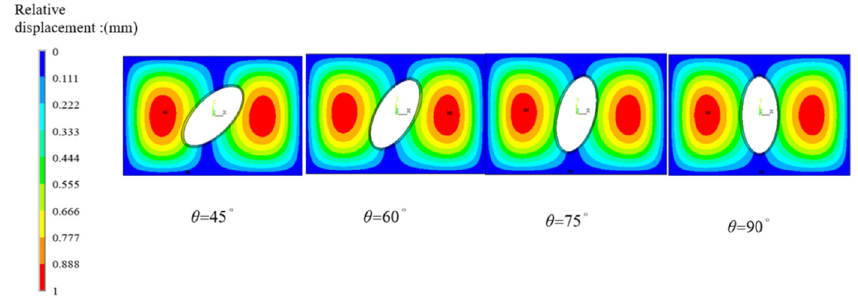
Figure 13: First - order buckling mode of the perforated plates with t = 2 mm.